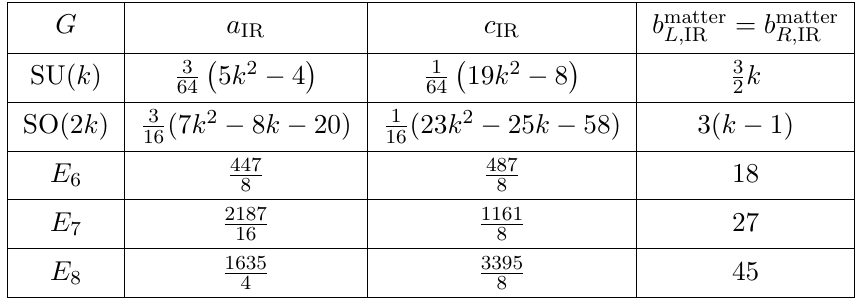
Table 1 . Values of a IR ; c IR ; b matter two G-type conformal matter sectors coupled by gauging the diagonal of two (out of the four) (cid:13)avor